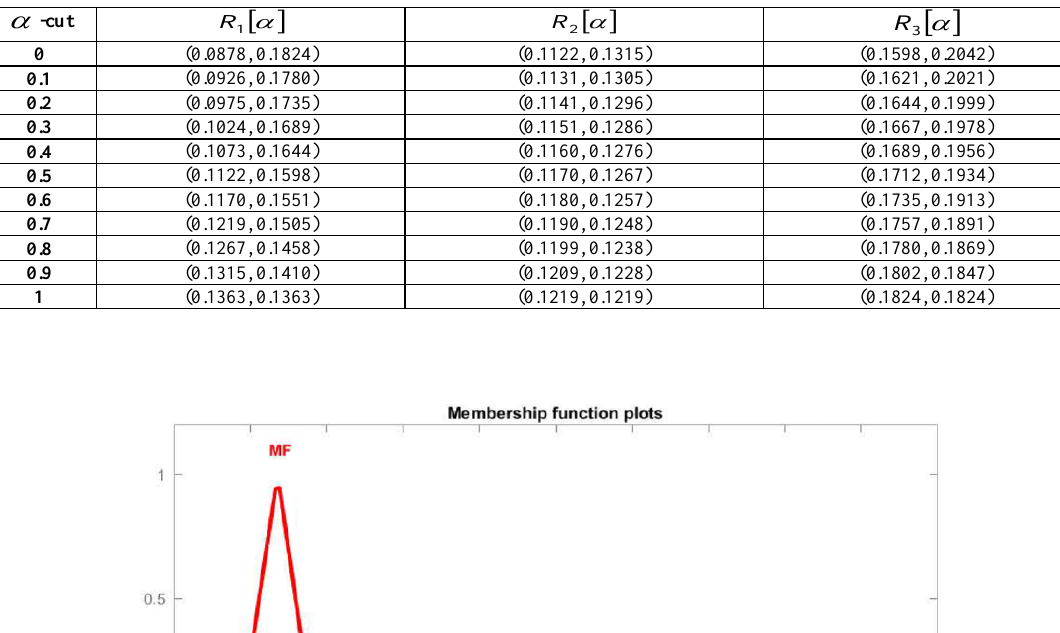
Figure 3. Membership function of R 3 ( α ) for linear system. Table 2. Reliability of the consecutive system.